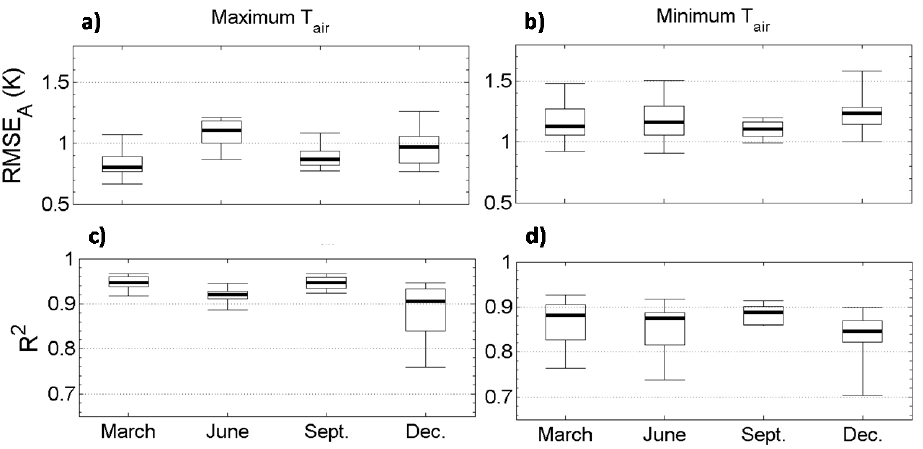
Figure 7. Idem to Figure 6, but corresponding to performance metrics obtained with the “complex” model.